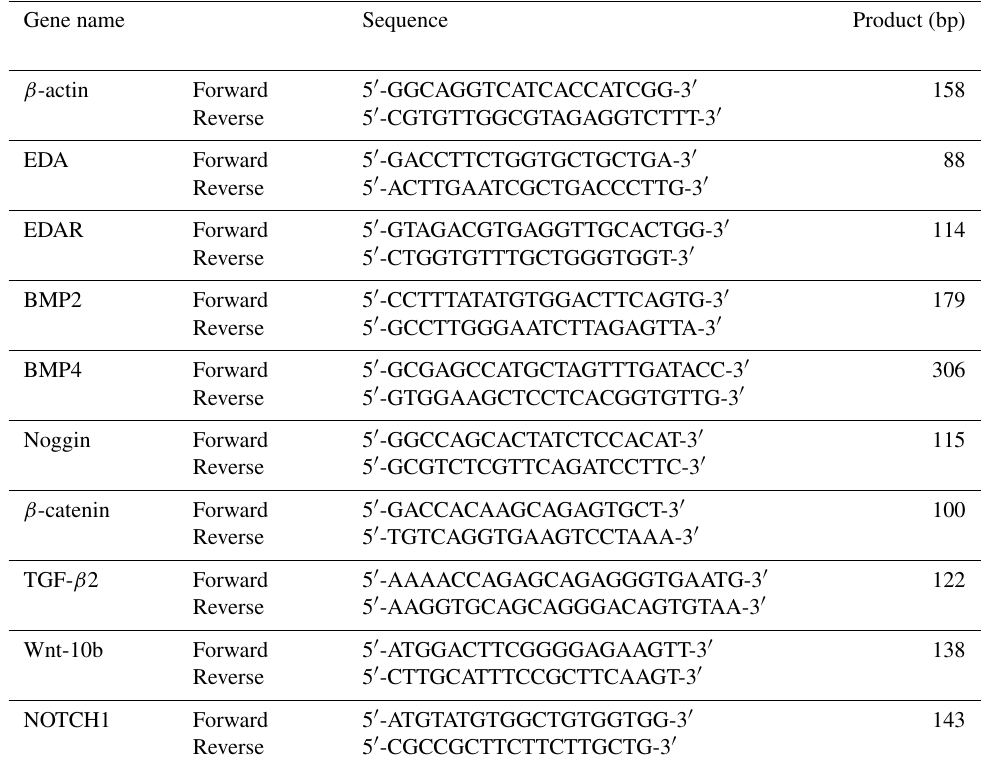
Table 1. The mRNA primer